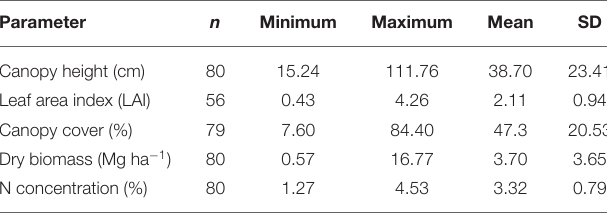
TABLE 1 | Descriptive statistics of the measured parameters for the finger millet. Parameter